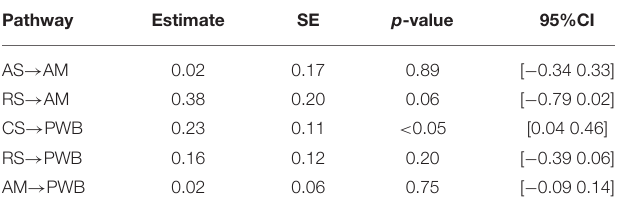
TABLE 3 | The moderating effect of culture (China/France) on the structural pathway coefficient between needs satisfaction, autonomous motivation, and